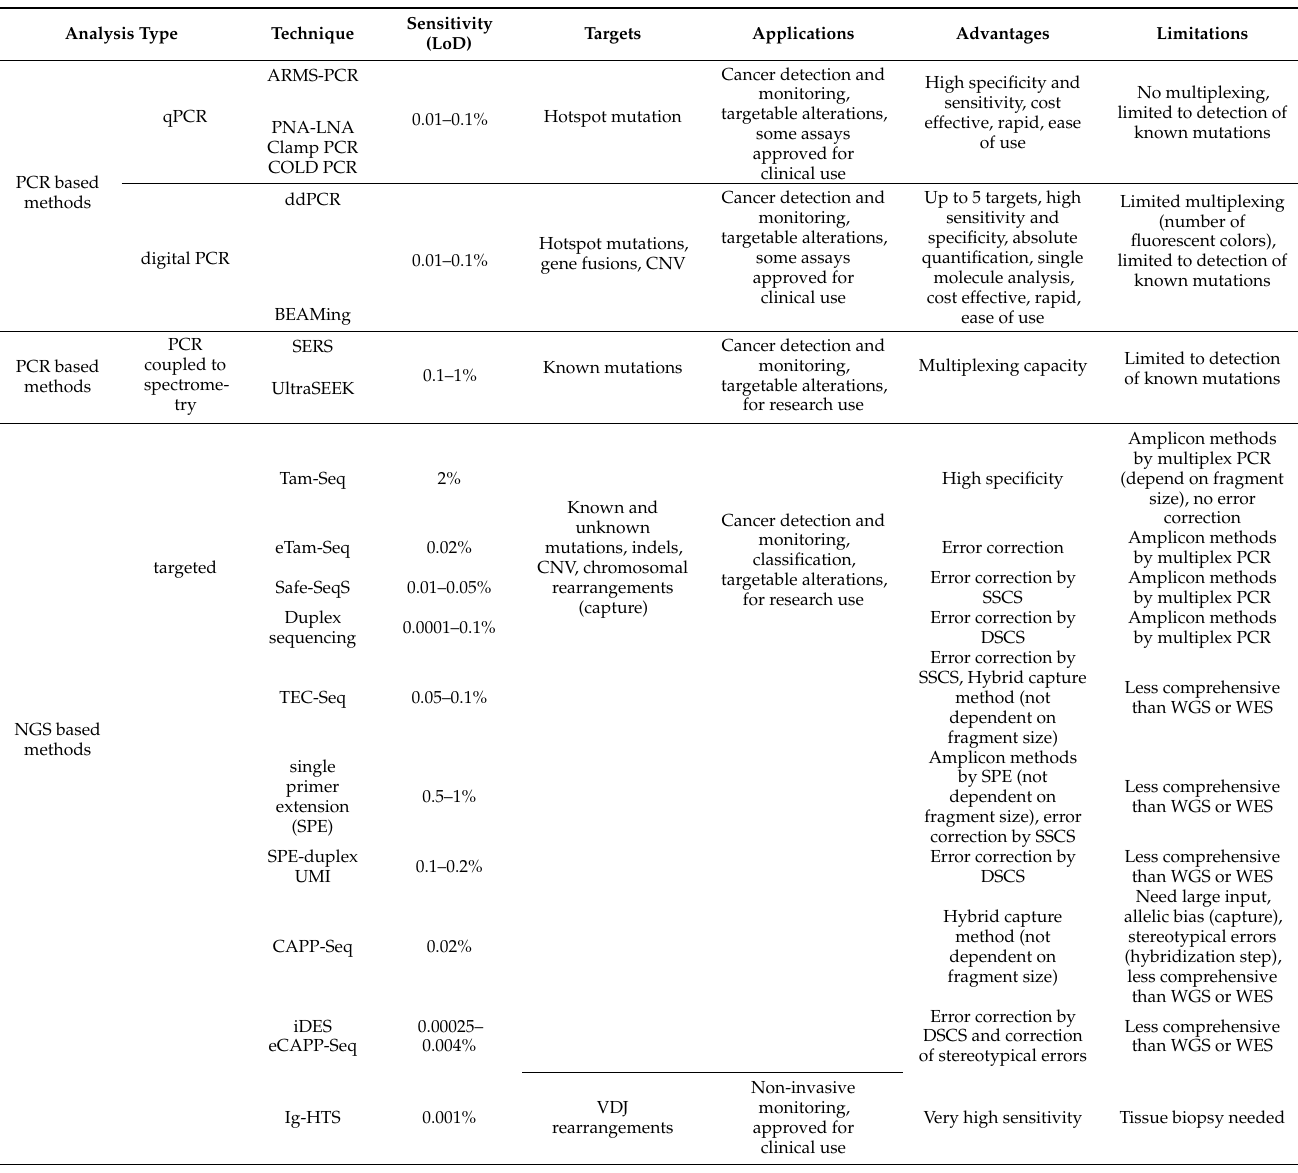
Table 1. Comparison of some sequencing technologies for ctDNA